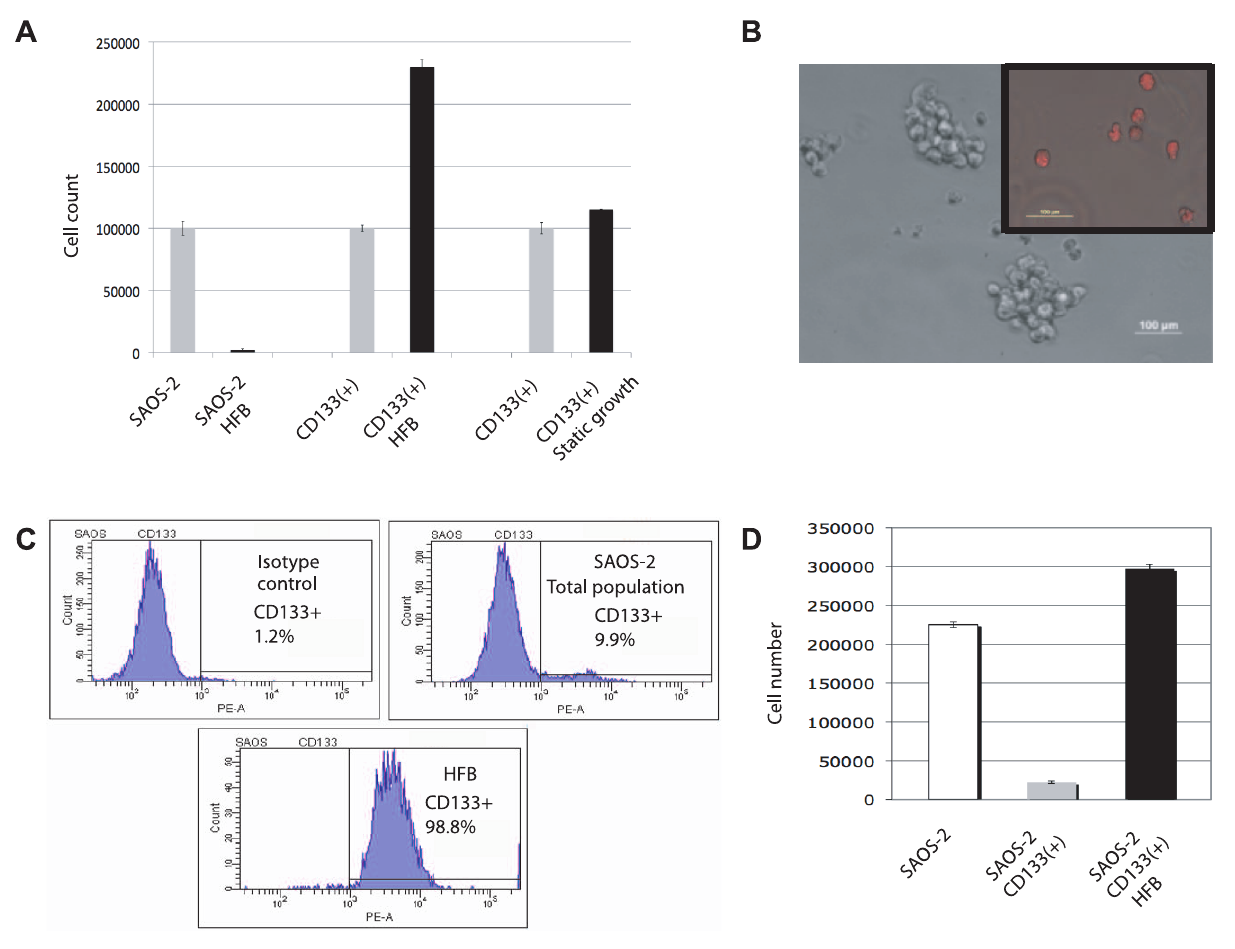
Figure 1. CD133( + ) SAOS-2 cells are selected in the hydrofocusing bioreactor. A) Trypan blue exclusion cell count of SAOS-2 cells (osteosarcoma cells) and SAOS-2 cells cultured in the HFB, CD133( + ) SAOS-2 cells and CD133( + ) SAOS-2 cells cultured in the HFB, and of CD133( + ) SAOS-2 cells and CD133( + ) SAOS-2 cells cultured in normal gravity condition. Gray bars indicate the number of cells placed in the control on day-1. Black bars indicate the number of viable cells recovered after 5 days of culture in that culturing condition. B) Bright field contrast phase image (20 6 ) of 3-D culture (spheres) formed from SAOS-2 cells that were grown in the HFB for 5 days. Inset (top right) shows an image of CD133 immunofluorescence staining of SAOS-2 cells grown in the bioreactor for 5-days. C) Flow cytometry chart of the CD133 immunophenotype of SAOS-2 cells. An isotype antibody was used as a control. D) Trypan blue exclusion cell counts of an optimized experiment of HFB culture of SAOS-2 cells in the HFB after seven days. CD133( + ) SAOS-2 cells cultured in the bioreactor were selected and proliferated 15-fold after seven days. White bar indicates the number of SAOS-2 cells seeded in the HFB. Black bar indicates the number of viable CD133( + ) SAOS-2 cells recovered after 7 days of optimized culture in the bioreactor. Gray bar indicate the number of CD133( + ) cells present in the parental SAOS-2 population. The data is representative of three separate experiments yielding comparable results.